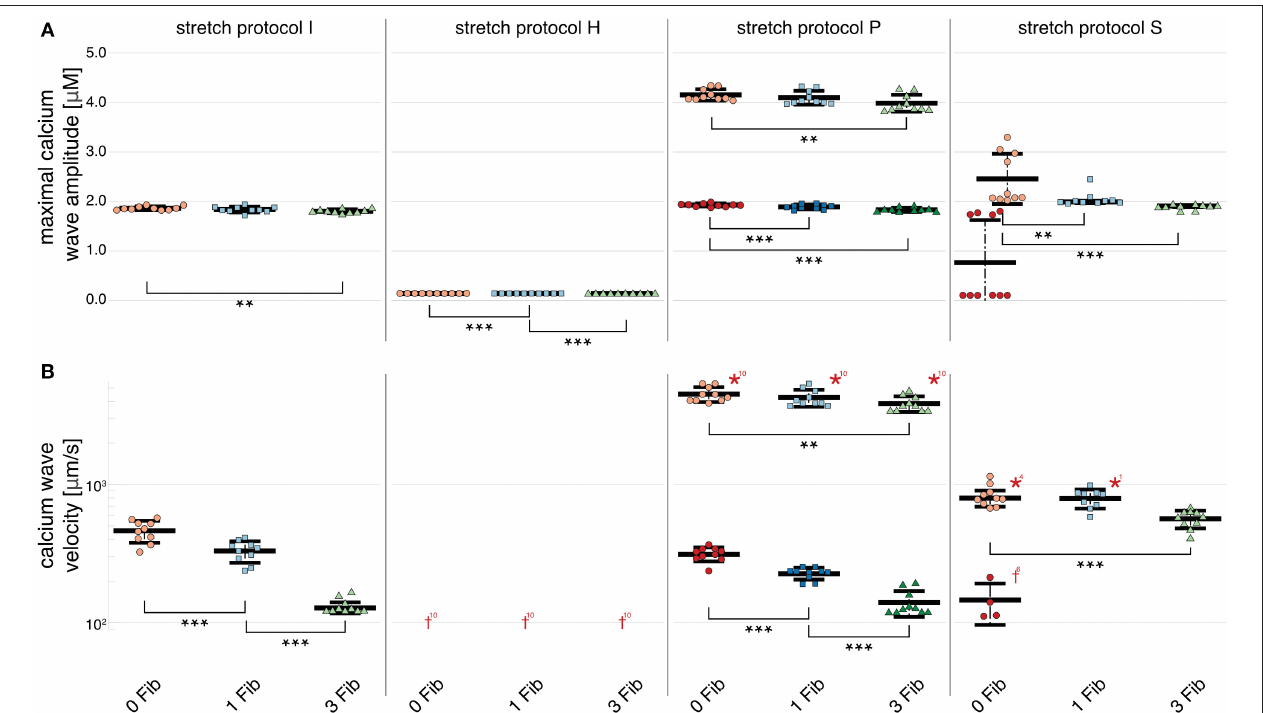
FIGURE 6 | Maximal calcium wave amplitude and calcium wave velocity for simulations of three coupled cardiomyocytes. (A) For all stretch patterns but H (from left to right: control, H, S, and P) the maximal calcium wave amplitude significantly ( p < 0.01) decreased the more fibroblasts were coupled to the multi-cellular string (control red data points, 1 coupled fibroblast blue data points, and 3 coupled fibroblasts green data points; the data points in light colors specify the first spontaneous event and dark colors are used for the following spontaneous event). (B) The wave velocity significantly ( p < 0.01) decreased for all stretch patterns from no coupled fibroblast to three coupled fibroblasts. *, **, *** indicate the statistical significance with p < 0.01, p < 0.05, and p < 0.1, respectively.